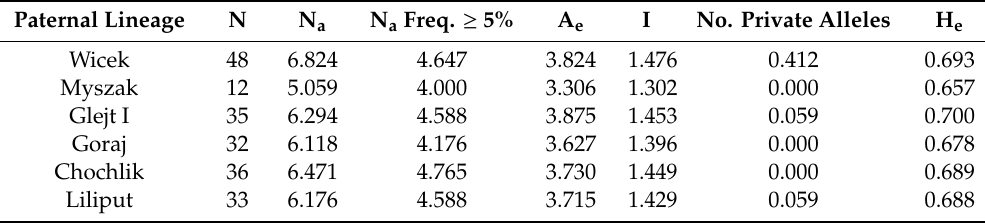
Table 1. Characteristics of 17 microsatellite loci in six paternal lineages ( n = 196).